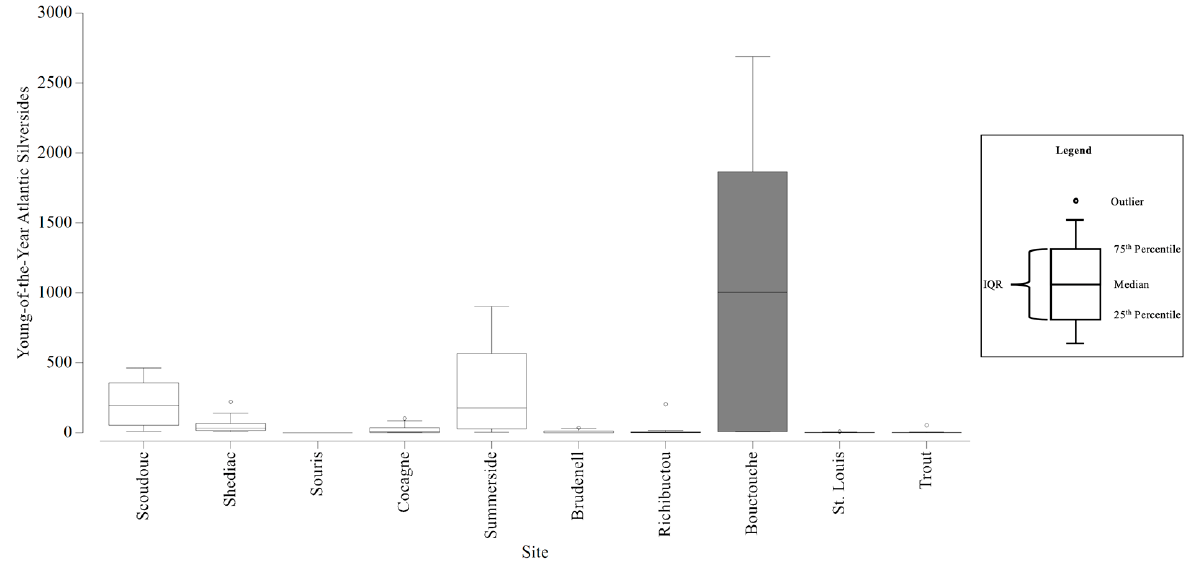
Figure 8. Boxplots generated using the young-of-the-year (YOY) Atlantic Silverside counts collected from the Community Aquatic Monitoring Program (CAMP) stations at each estuary. The box shaded dark grey identifies the YOY Atlantic Silverside abundances that are significantly different from the abundances at the other estuaries, and the difference is large enough to be detected, with confidence, in consideration of the precision of the CAMP sampling design. Circles above the boxplots (i.e., outliers) are outside 1.5 times the interquartile range